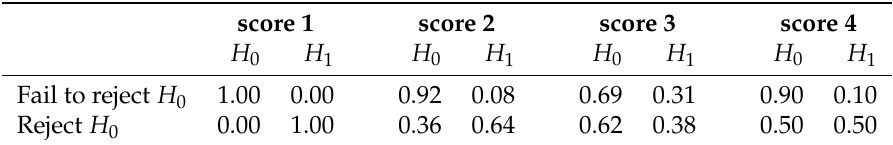
Table 10. True rate of false positives and false negatives for each of the four scores when the size of the samples to diagnose is ν = 50.